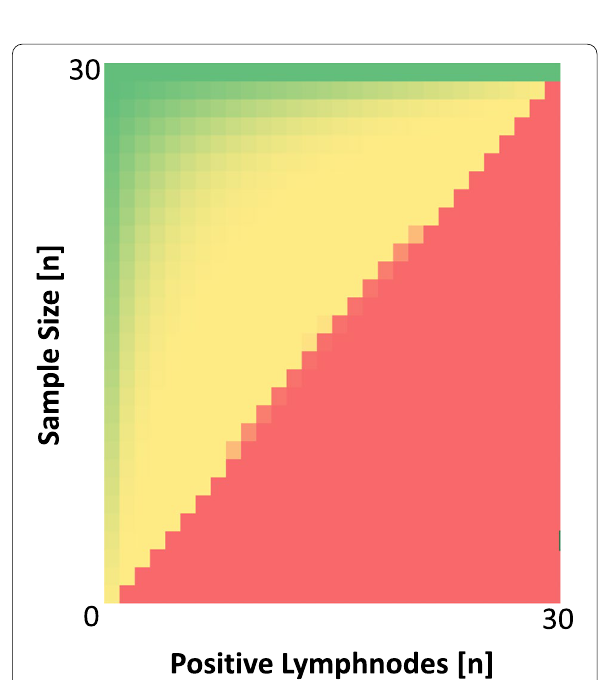
Fig. 3 Extent of Lymphadenectomy needed in a therapeutic context. Extent of D2-lymphadenectomy for complete resection of positive lymph nodes in dependence from number of positive lymph nodes. Green color: 95% probability or more; red color: 0%